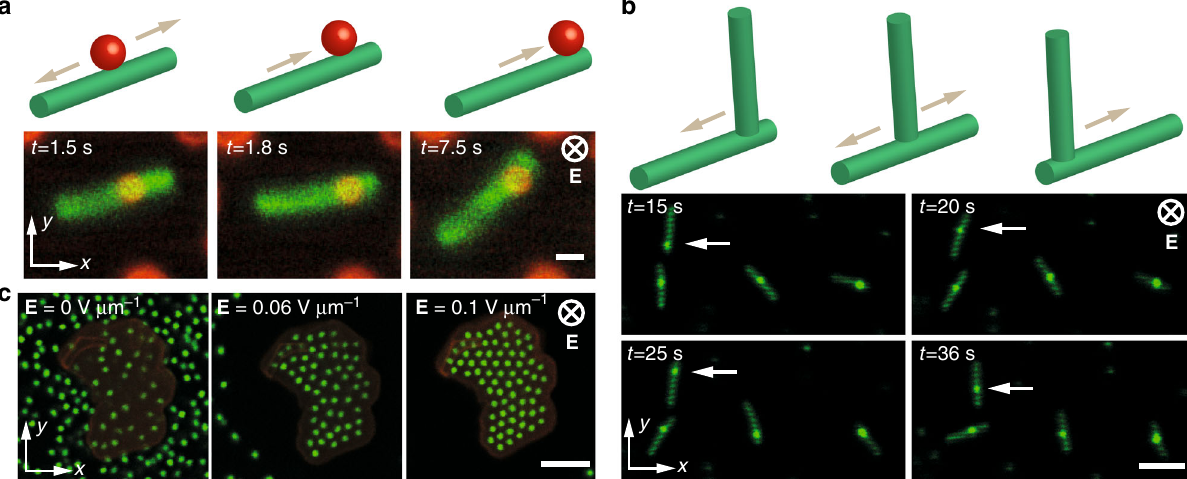
Fig. 2 Trapping and assembly of cargo colloids by various colloidal shuttles. Rod-shaped particles act as colloidal shuttle, which trap other smaller colloids used as cargo colloids. Because the shape of the trap is anisotropic as the colloid, the smaller Brownian cargo explores the space above the colloidal shuttle along the long axis of the rod. a A 1 μ m sized fl uorescent silica colloid (red) is trapped over a larger silica rod (green) with an aspect ratio of 5. Above panels in a , b depict side view of the motion and assembly of colloids over time. b Horizontally lying colloidal rods trap others rods, which are aligned along the electric fi eld. Standing rods move along the lying rod over time. c An alumina platelet labeled with rhodamine is used as a colloidal shuttle to trap 1 μ m sized fl uorescent silica colloids. In the absence of electric fi eld particles are spread all over the space. When a fi eld is applied particles start to move towards the alumina particle and accumulate over it. Further increasing the fi eld increases the local concentration of the smaller colloid and result in a phase change from a liquid to a crystal. Scale bar in a is 1 μ m and in b , c is 5 μ